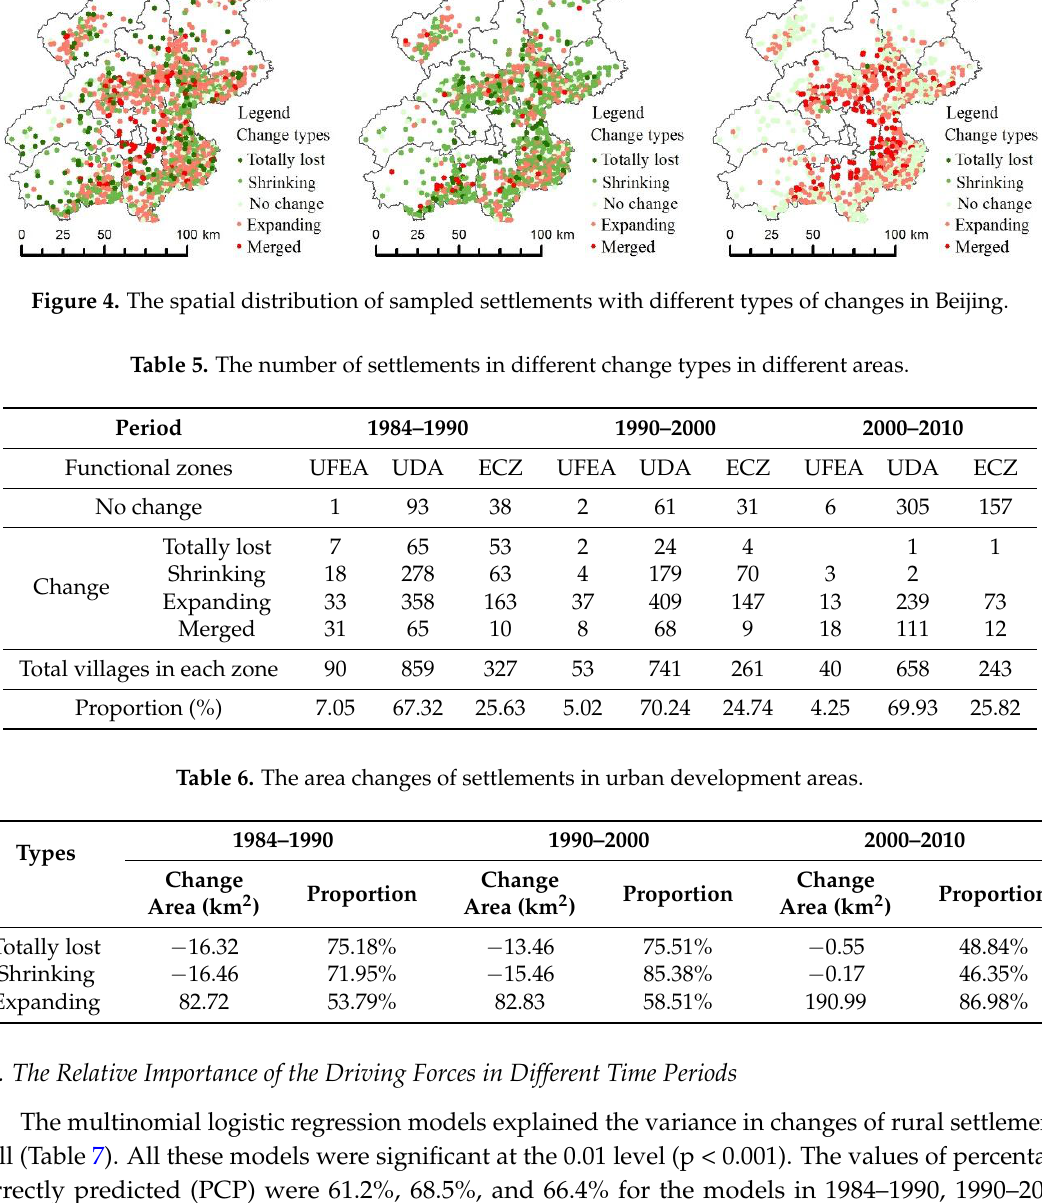
Table 7. The effects of driving factors on the changes of rural settlements.